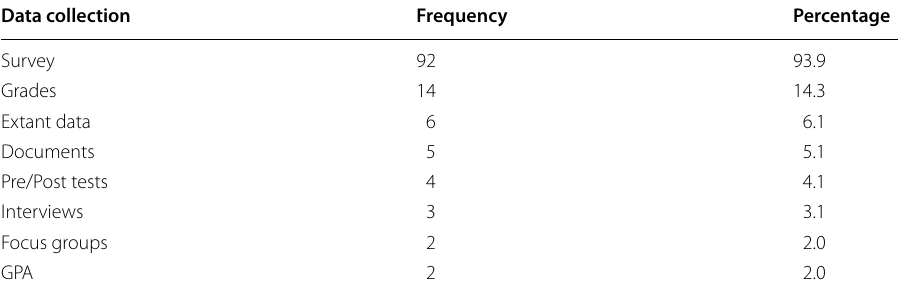
Table 8 Data collection methods